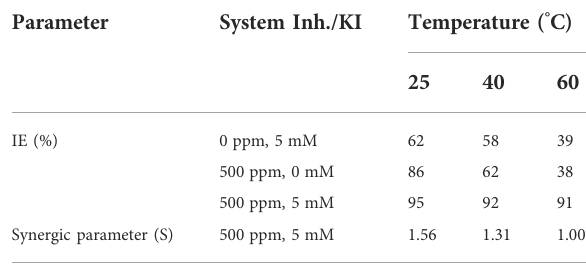
TABLE2Synergismparametercalculatedfor500 ppmof M.sativa and the 5 mM KI system. Parameter